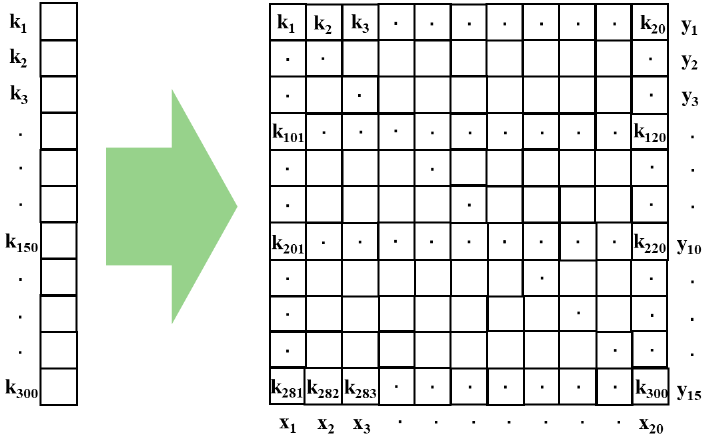
Table 4. Confusion matrix and accuracy of Bp-ANN identification model for three samples.